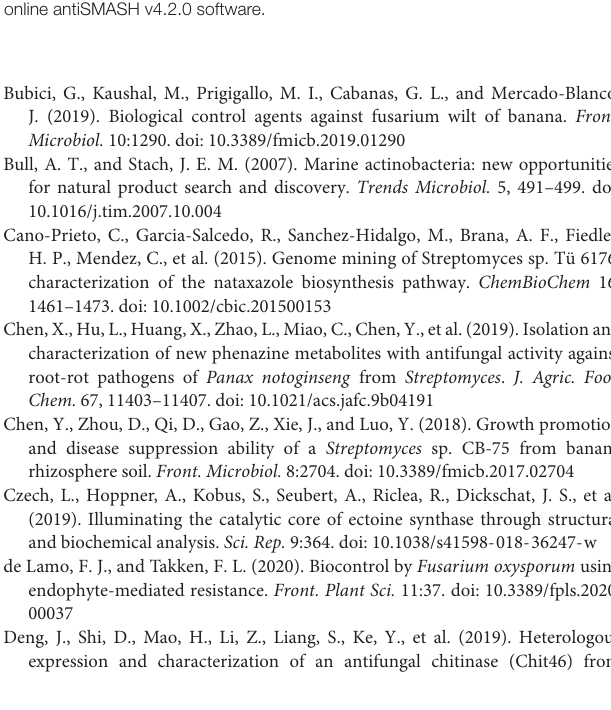
Supplementary Table S1 | Antibiotic sensitivity test of Streptomyces BITDG-11. Supplementary Table S2 | Calculation of ANI value. Supplementary Table S3 | Genome-wide analysis of Streptomyces BITDG-11 for biosynthesis gene clusters of the biosynthesis of secondary metabolites by